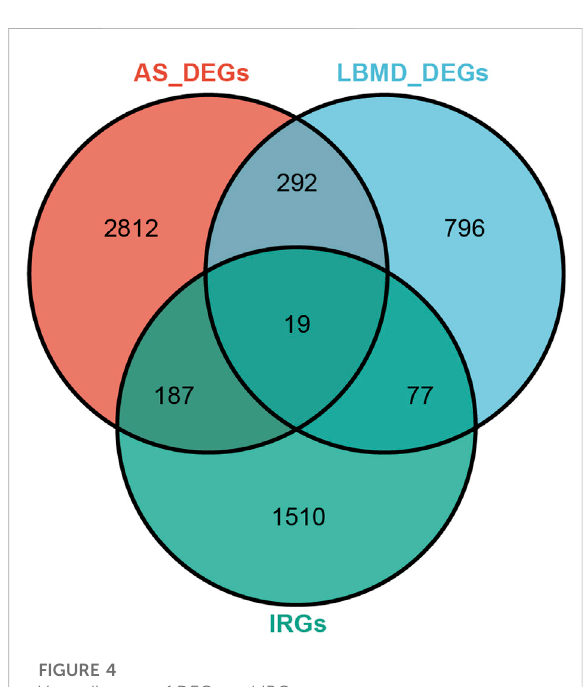
FIGURE 4 Venn diagram of DEGs and